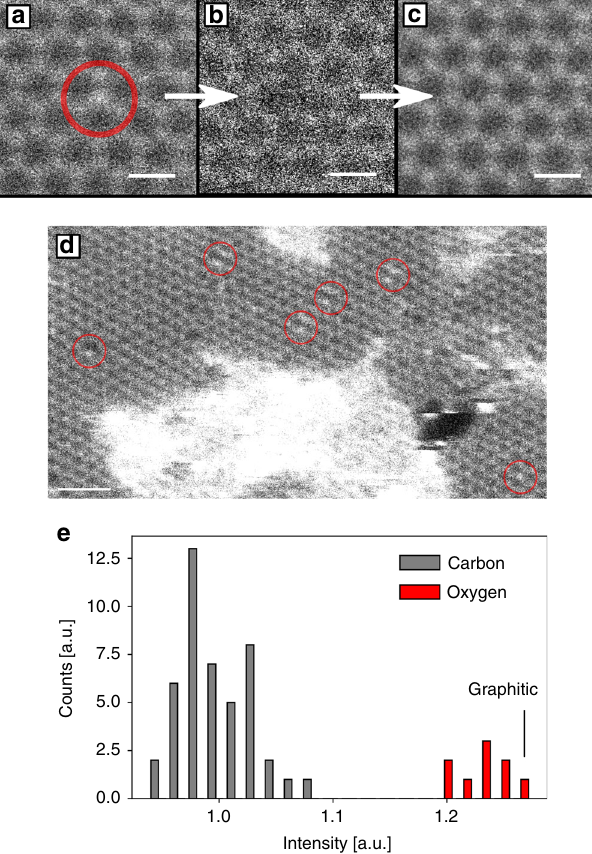
Fig. 3 Graphitic oxygen substitution. a Unprocessed STEM image of a graphitic oxygen substitution in graphene. b Oxygen atom is sputtered after four frames, leaving a vacancy. c Pristine graphene lattice after the vacancy gets re fi lled by a carbon atom. d Low-magni fi cation image of the GO sample, where multiple pair con fi gurations and a graphitic substitution is present. e Histogram of intensity distribution of atoms in panel d . Scale bars in panel a – c and in panel d are 0.25 and 1 nm,